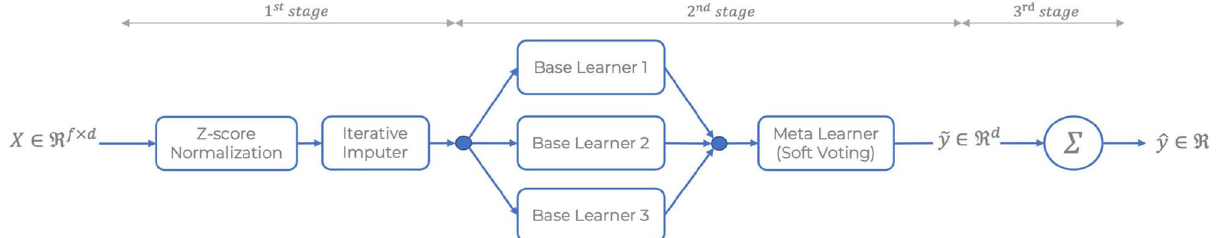
Figure 4. The classification pipeline for a given clinical outcome inference is a three-stage non-linear mapping, formally (cid:31) : ℜ f × d → ℜ . The pipeline requires a matrix containing f composite scores generated over d consecutive days as an input for a single subject. During the learning phase, the time window of length d is centred around the clinical visit where EDSS, NHPT, and SDMT scores are recorded. The matrix values are subsequently normalized, and missing values (due to insufficient data within a day) are imputed via chained equations 22,23 , a.k.a. Iterative Imputer. The second stage pipeline delivers an output ˜ y ∈ ℜ d with d predicted probabilities coming from an ensemble model composed of three classifiers (two for the clinical diagnosis) pointing to a soft voting meta learner. The third and last stage of the pipeline yields the actual prediction denoted as ˆ y ∈ ℜ obtained by averaging the probabilities, i.e. ˆ y = (cid:31) d i = 1 ˜ y i . Depending the target and the corresponding feature set, ˆ y provides the estimation relative to the clinical diagnosis (HC versus pwMS), disease severity level based on EDSS, manual dexterity and cognitive function level based on NHPT and SDMT,